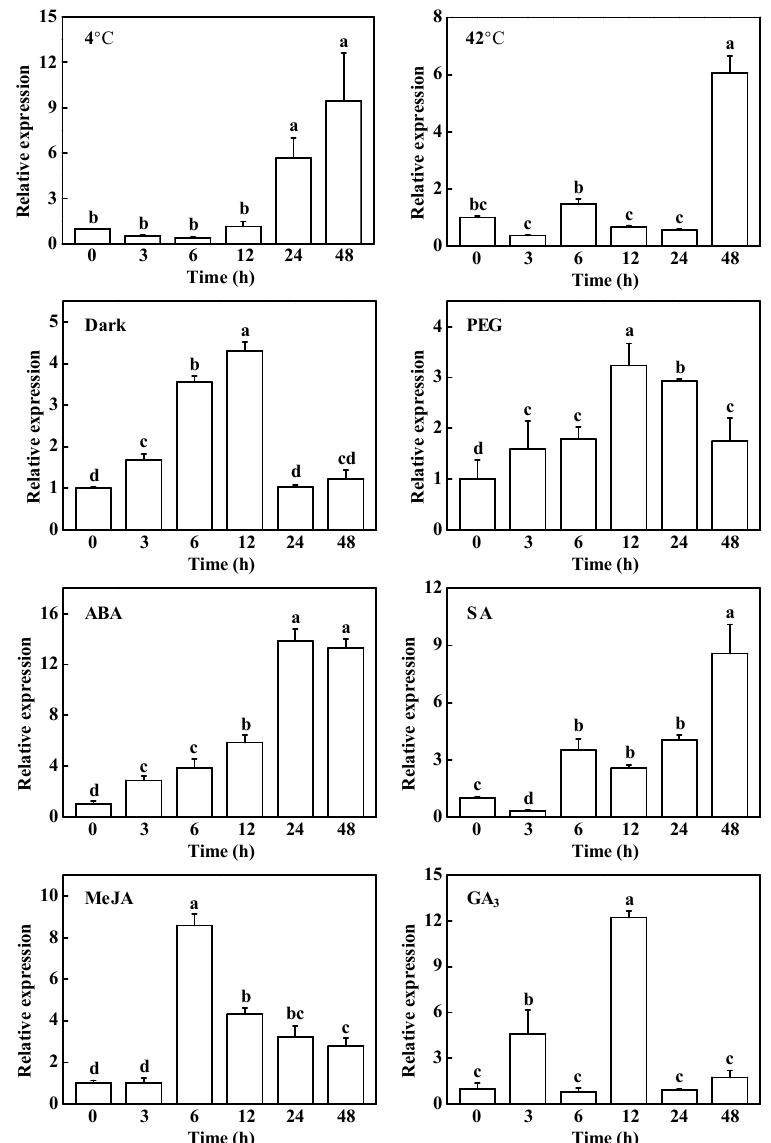
Figure 3. Expression patterns of CsHCAR in cucumber leaves under different abiotic stresses and phytohormone treatments. 4 ◦ C, 42 ◦ C, dark, and PEG represented cucumber plants treated with cold, heat, darkness, and drought stress, respectively. ABA, SA, MeJA, and GA 3 represented cucumber foliar treated with 100 µ M ABA, 100 µ M SA, 100 µ M MeJA, and 100 µ M GA 3 , respectively. The leaf samples were collected at the indicated time points and analyzed by qPCR. The results represent the mean ± SE ( n = 3). Means with the same letter did not significantly differ at p < 0.05 according to Tukey’s